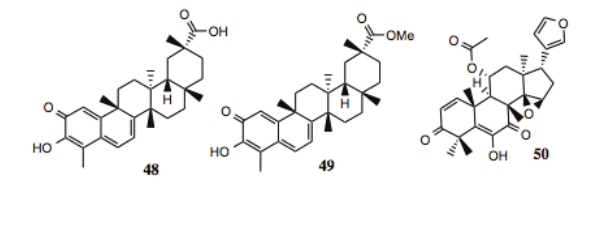
Figure 6. Pentacyclic